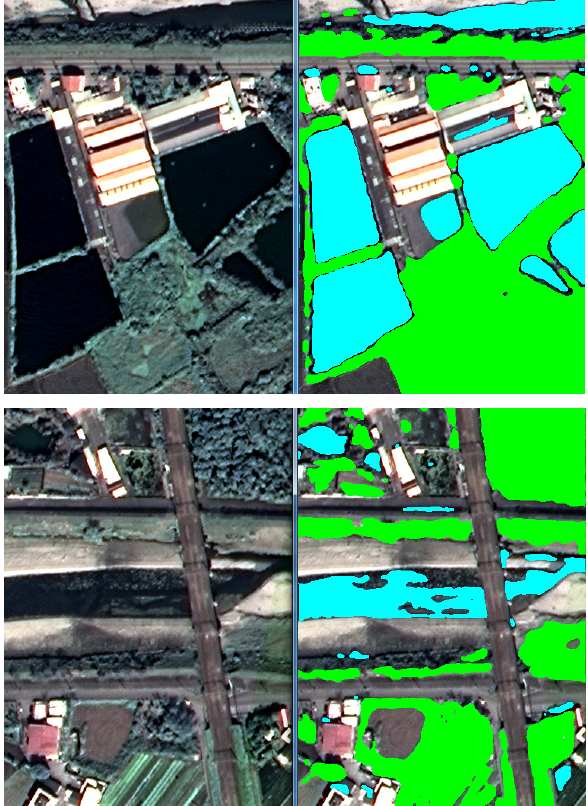
Figure 8. An example of automated recognition of vegetation and water objects for two test sites on the images of the Hualian city from the SuperView-1A satellite for January 18, 2018 with the same settings of binarization thresholds The overall classification accuracy in this case was slightly worse and amounted to from 82% to 90% with the kappa coefficient from 0.80 to 0.85. The main error in the classification results is caused by shaded areas, which are falsely recognized as water. This problem is typical for both satellite images of submeter resolution, and for aerial